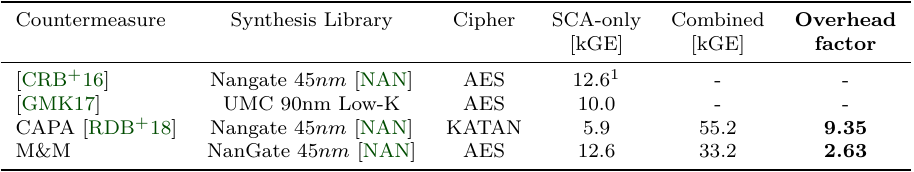
Table 4: Area comparison for second-order secure implementations